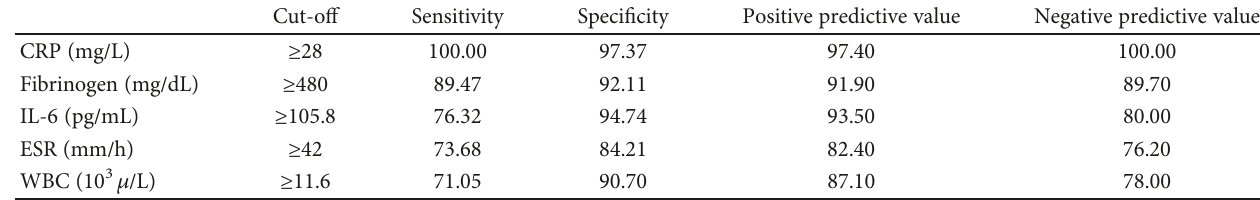
Table 4: Sensitivity, speci fi city, negative predictive value, and positive predictive value of in fl ammatory marker. Cut-o